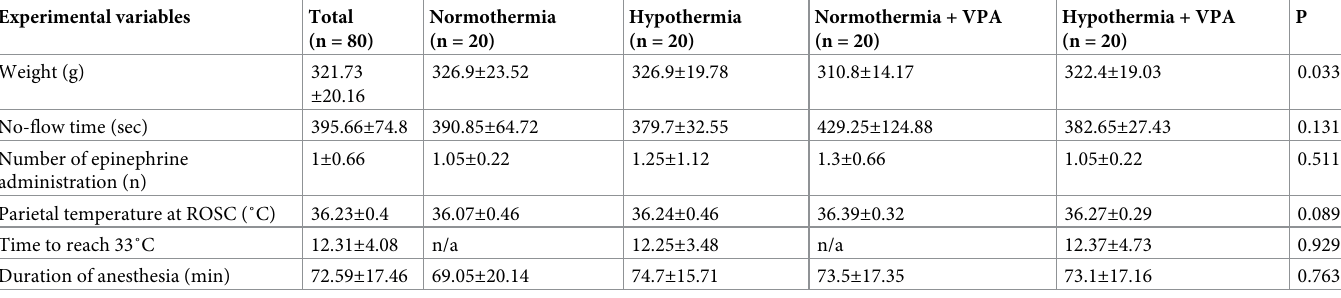
Table 1. Comparison of experimental variables between